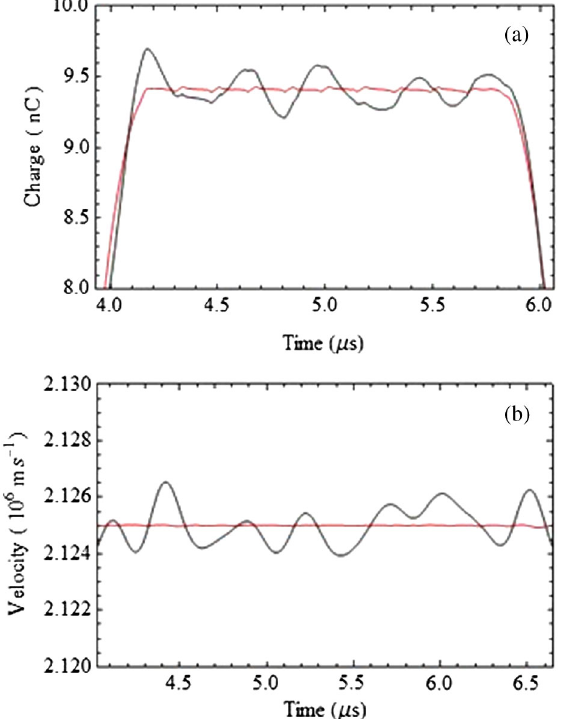
gap.FIG. 11. (a) The line-charge density profile to show the per- . (b) The beam velocity profile to show the formance of DEC at z 2 þ 0 : 72 m performance of VEC at z 2